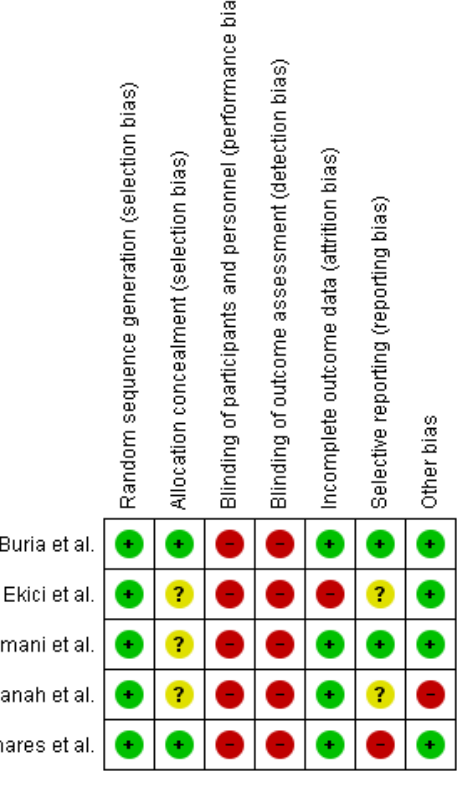
Figure 2. Risk of bias summary: a review of authors ’ judgments about each risk of bias item for each included study [13,32 – 35]. Red ( − ) = high risk of bias, yellow (?) = unclear risk of bias, green (+) = low risk of bias.